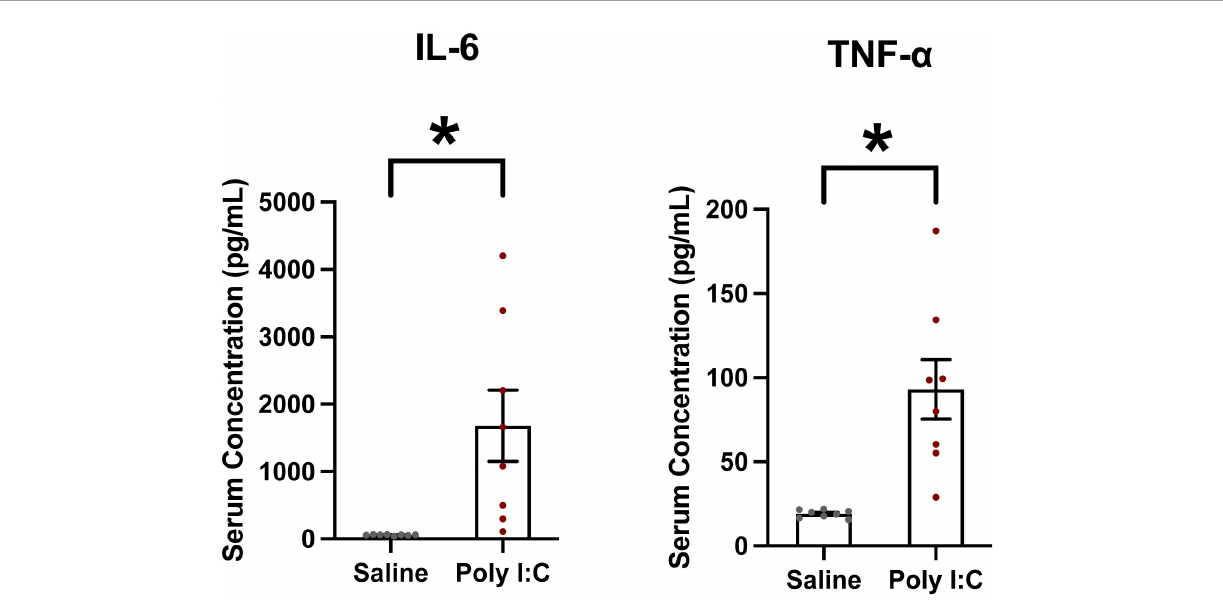
FIGURE2 Poly I:C MIA significantly increases circulating levels of proinflammatory cytokines Interleukin-6 (IL-6) and Tumor Necrosis Factor α (TNF α ) in maternal serum. Serum samples were collected 3 h following Poly I:C injection and quantified using ELISA. Both IL-6 and TNF α were significantly elevated in serum from Poly I:C-treated dams compared to saline-treated dams. Data are shown as mean ± standard error, * p < 0.05. Individual dots represent individual dams ( n = 8 per